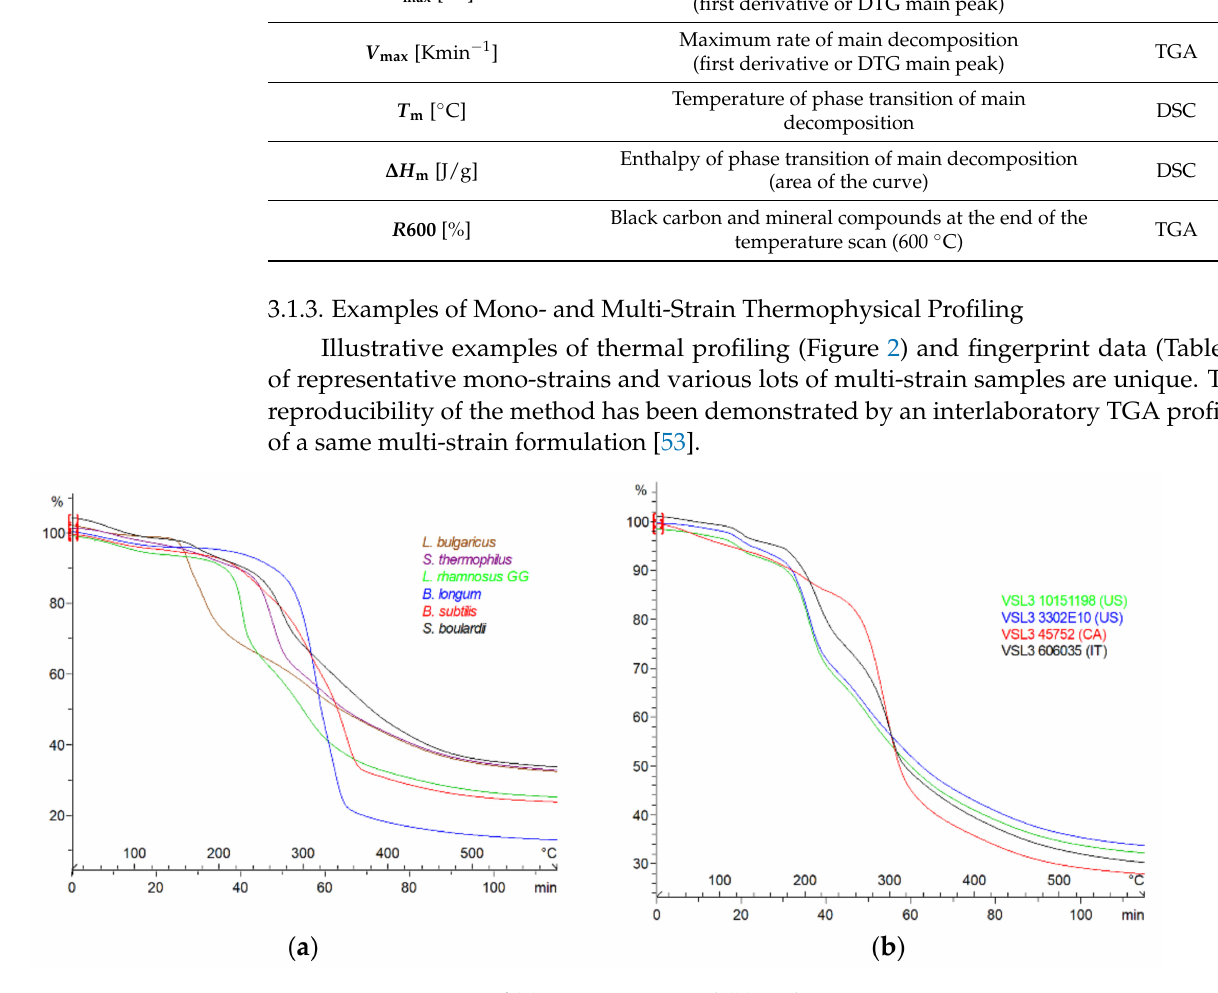
Figure 2. TGA curves of ( a ) mono-strains and ( b ) multi-strains. Table 3. Thermophysical data of mono-strain and multi-strain (VSL#3) samples of probiotic formulations. Probiotic